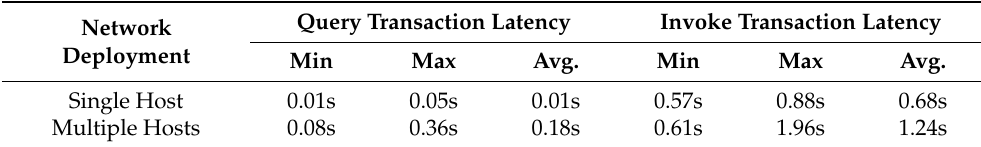
Table 3. Performance of Raft Network on Different